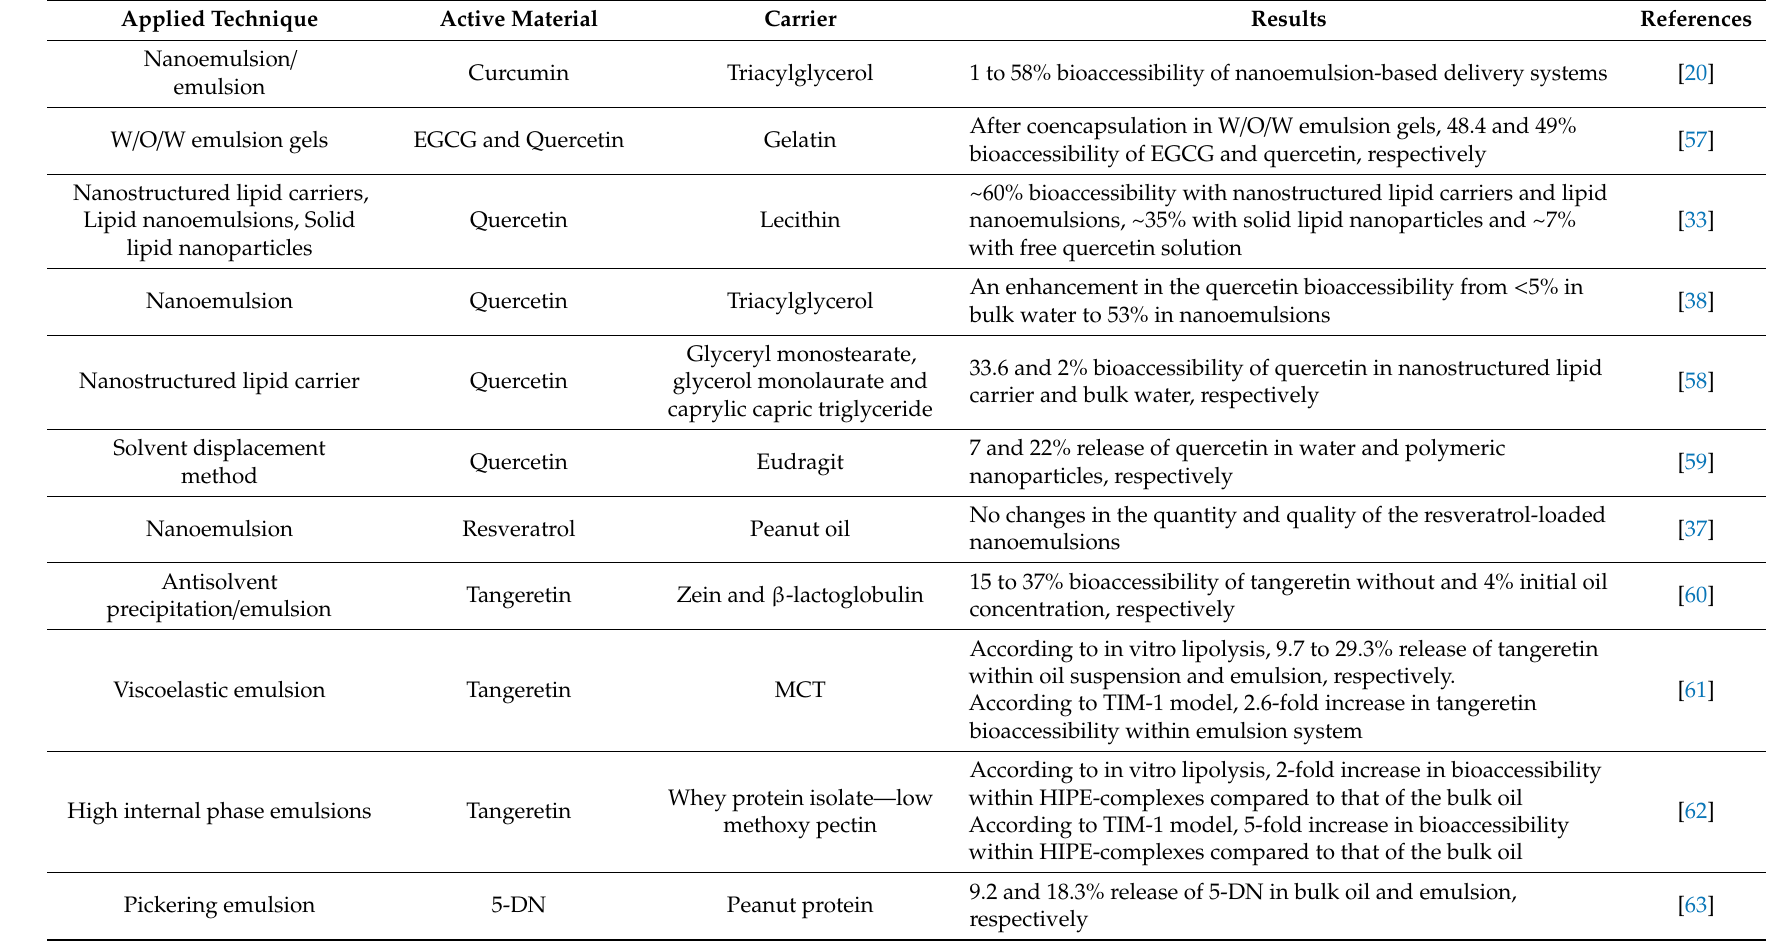
Table 1. E ff ects of di ff erent lipid-based encapsulation techniques on the bioaccessibility of selected phenolic